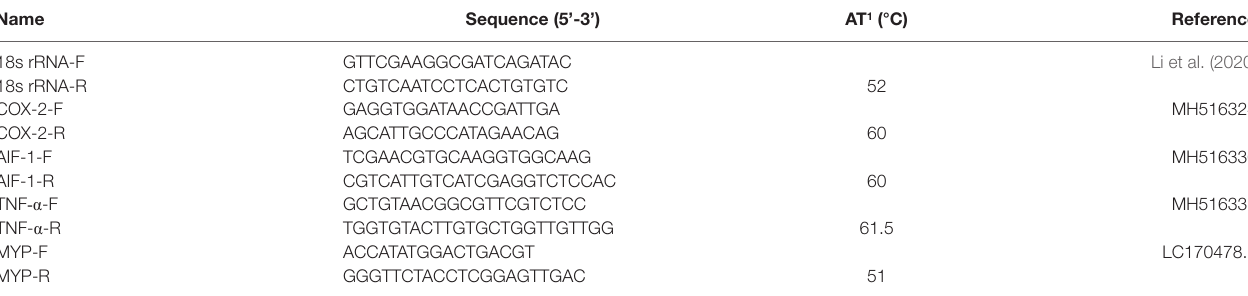
TABLE 3 | List of primers used for real time PCR in this